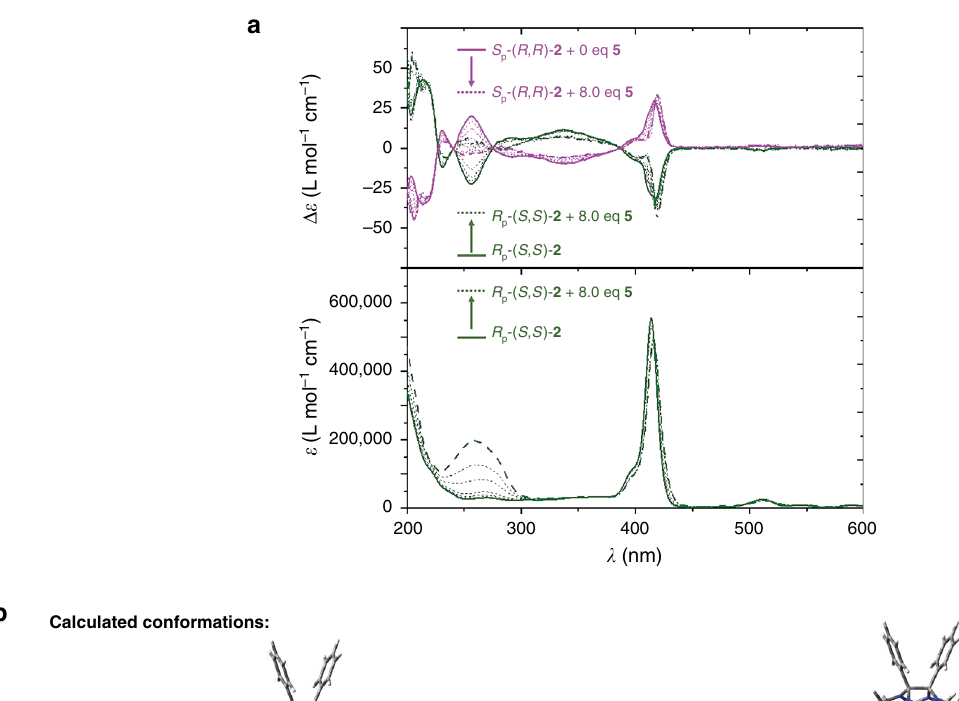
host – guest complex is formed, the π − π * absorption band of the guest shifts to lower energies (bathochromic shift) and appears in an area where the host absorbs less. For the ( M )- 5 enantiomorph, the ECD band of the π − π * transition at 248 nm transition is positive. The bathochromic shift of the π − π * band in the complex superimposes it on the negative band at 264 nm of the host, thus canceling the signal, in agreement with the experiments (Fig. 5a). The calculations clearly show that the ICD phenomenon essen- tially results from the presence of only the ( M )-enantiomorphic